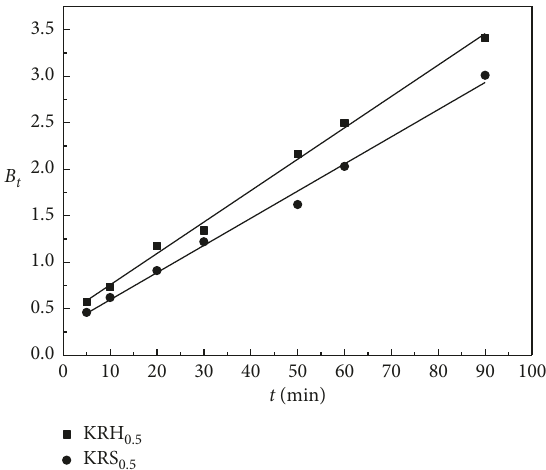
Figure 9: Boyd plot for adsorption of MG onto KRH